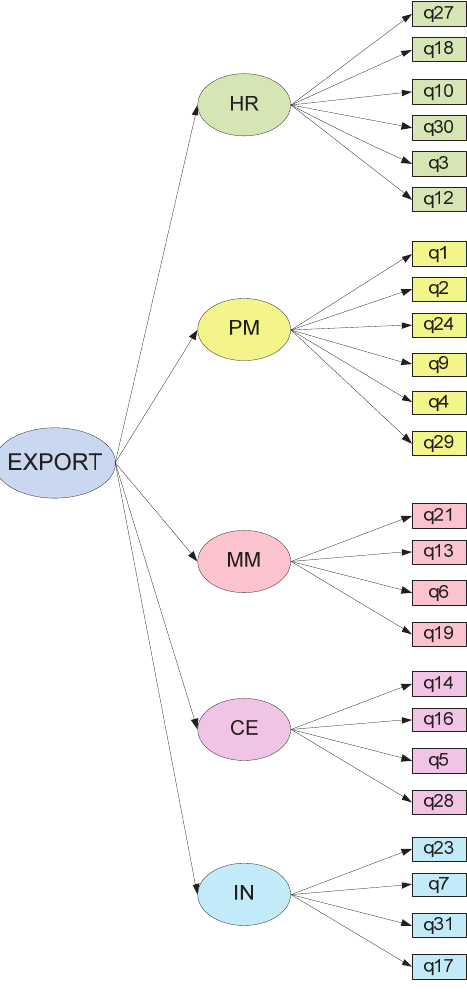
Fig. 1. The proposed